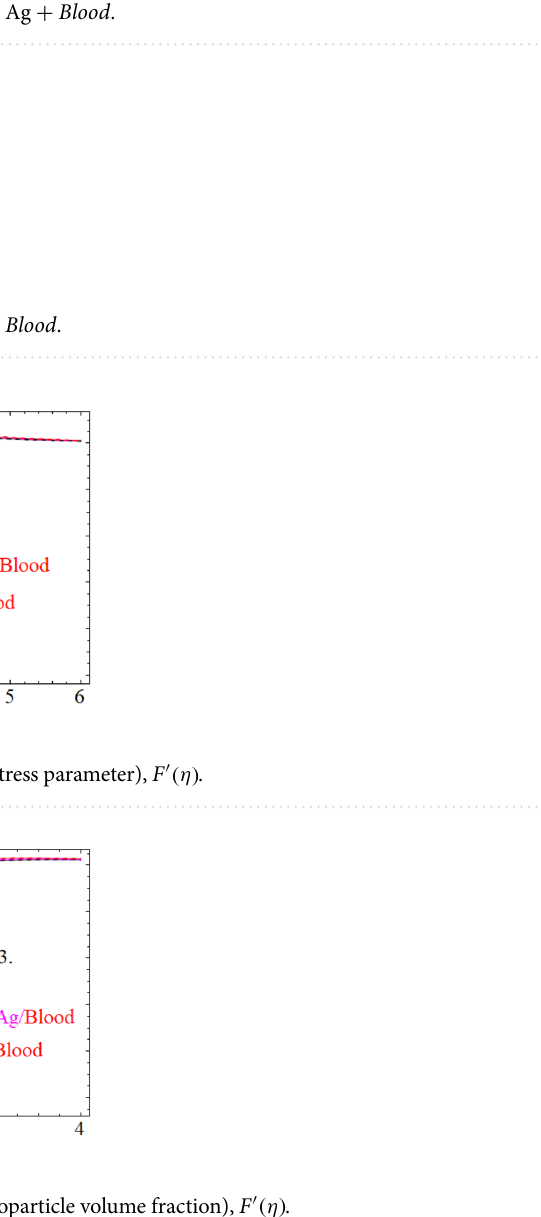
Table 7. Convergence of OHAM for TiO 2